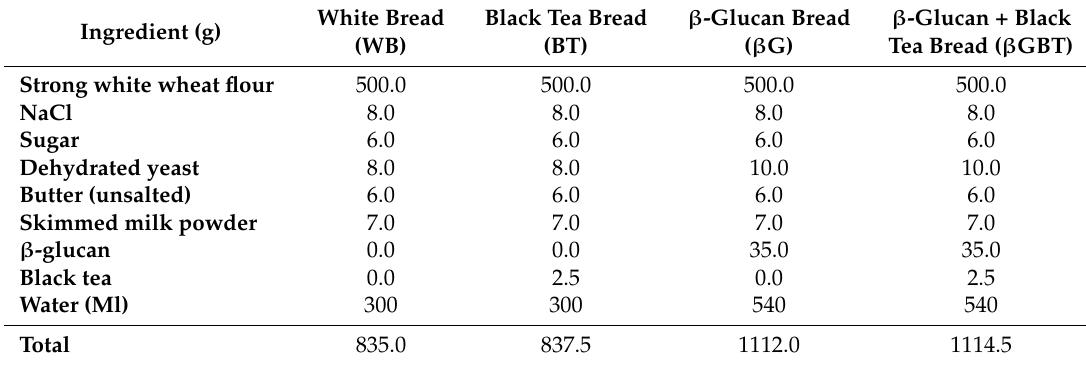
Table 1. Nutrient composition of experimental